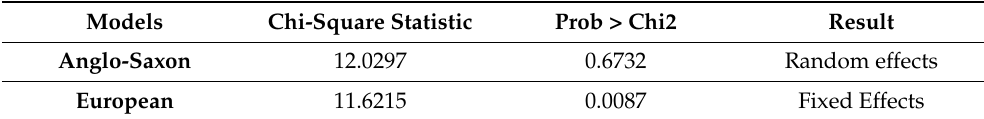
Table 6. Results of Hausman